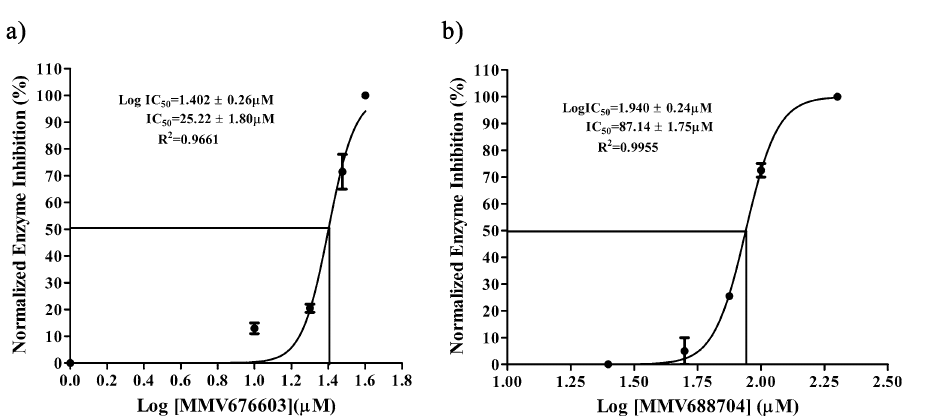
Figure 4. IC 50 determination of the compounds MMV676603 and MMV688704 against PfUCHL3 activity: dose–response curve indicating the Log IC 50, IC 50 and R 2 values of ( a ) MMV676603 and ( b ) MMV688704 against recombinant PfUCHL3. Inhibition at each data point is depicted as Mean ± S.D. of three independent experiments.